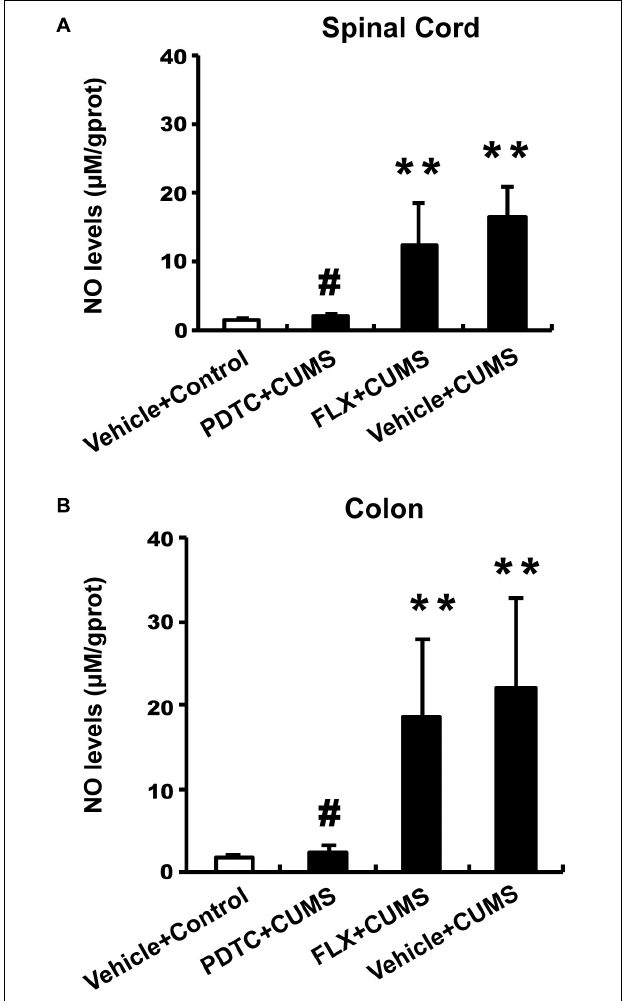
FIGURE 4 | Pyrrolidine dithiocarbamate but not fluoxetine inhibited CUMS-induced production of NO in both spinal cord and colon. The CUMS group and fluoxetine-pretreatment group showed significantly higher levels of NO content in both the spinal cord (A) and colon (B) compared to the control group. PDTC pretreatment significantly decreased the level of NO content compared to the CUMS group in both spinal cord (A) and colon (B) . All values are presented as mean ± SEM. n = 10 and ∗∗ p < 0.01, versus the control group. # p < 0.05 versus the CUMS group. FLX,